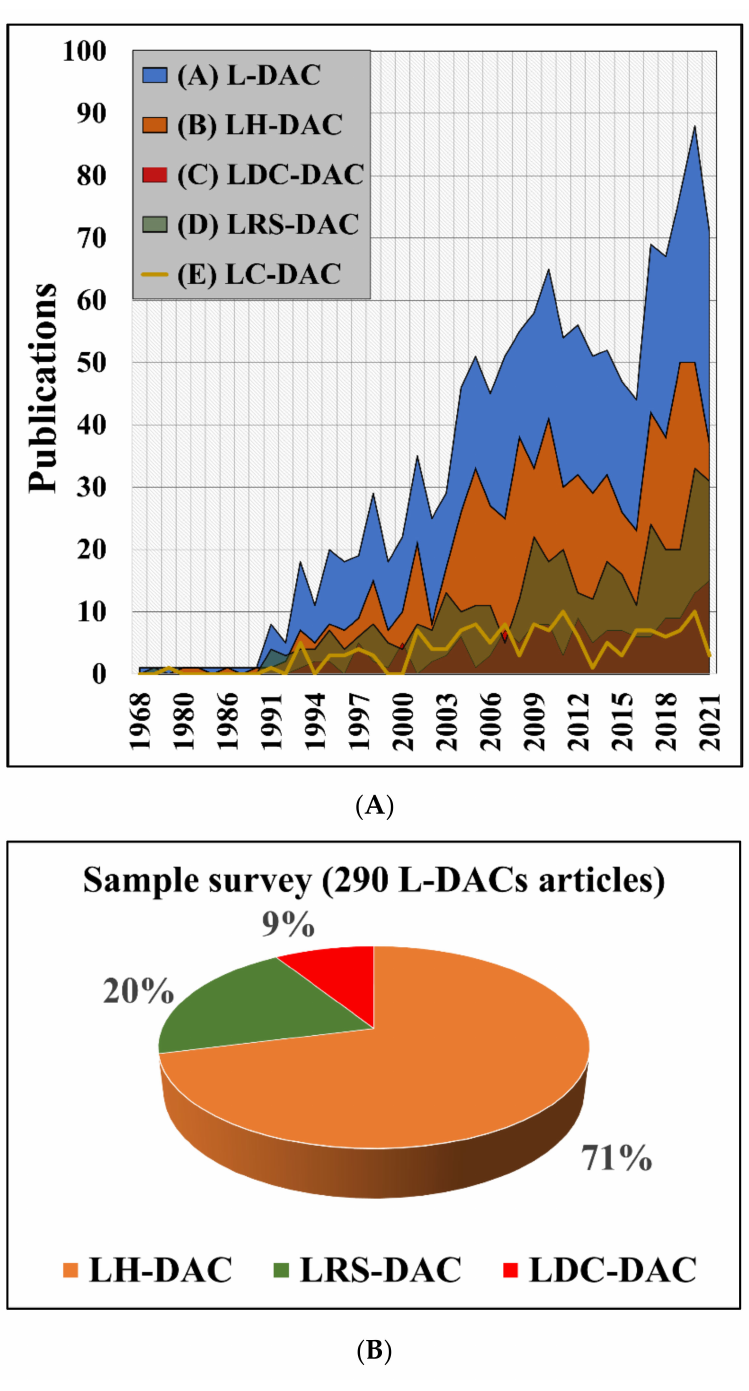
Figure 1. ( A ) Total annual scientific production for all L–DAC studies [Blue] compared with laser heated DAC (LH–DAC) [Orange], laser reactive synthesis DAC (LRS-DAC) [Green], and laser-driven dynamic compression DAC (LDC–DAC) [Red] studies [7]. ( B ) Comparison of the total number of articles produced in